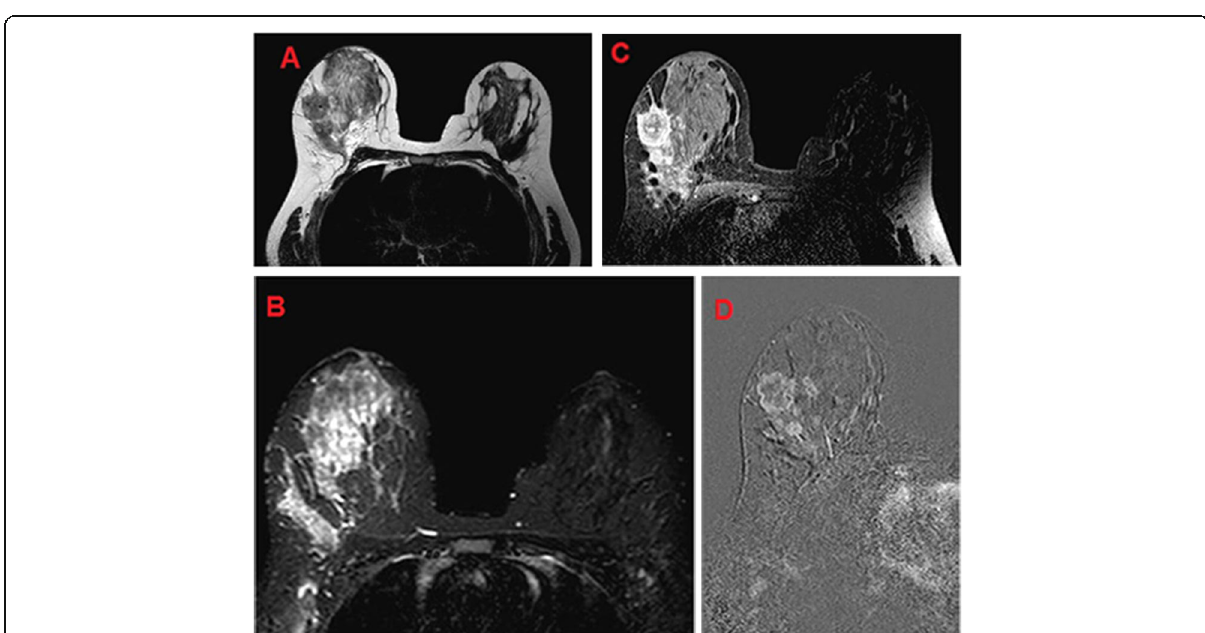
Fig. 1 MR images: a T2. b STIR. c DCE-MRI post-contrast. d DCE-MRI subtraction images. A large right upper outer quadrant (UOQ) irregular mass with a speculated margin is seen eliciting intermediate T2 and high STIR signal intensity “ arrow ” with multiple foci surrounding the lesion are also seen displaying intermediate T2 and bright STIR signal intensity “ arrowheads. ” On dynamic post-contrast images the enhancing mass “ arrow ” and the multiple peri-lesional foci all show rim enhancement “ arrowheads ” The pathology revealed TN invasive ductal